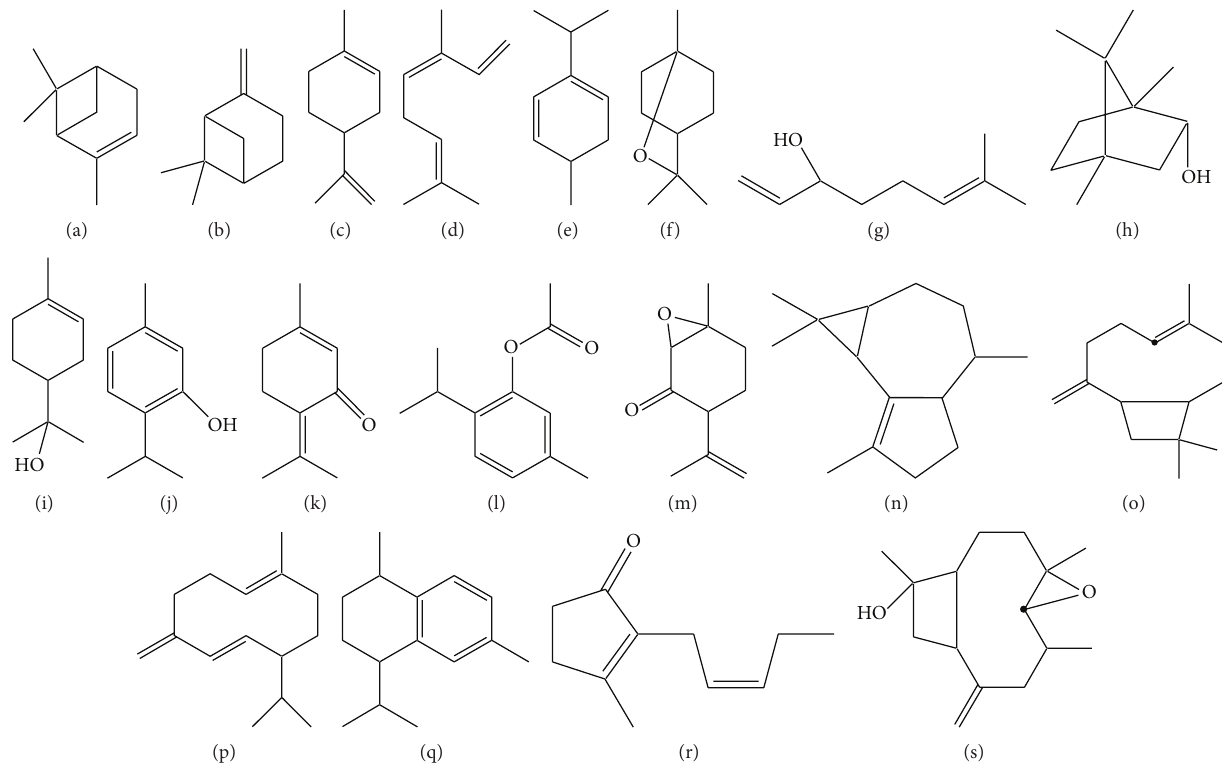
Figure 1: Structure of major compounds detected from M. longifolia essential oil. (a) 𝛼 -Pinene; (b) 𝛽 -pinene; (c) limonene; (d) cis - 𝛽 -ocimene; (e) 𝛿 -terpinene;(f)1,8-cineole;(g)linalool;(h)borneol;(i) 𝛼 -terpineol;(j)thymol;(k)piperitenone;(l)thymolacetate;(m)piperitenoneoxide; (n) 𝛼 -gurjunene; (o) 𝛽 -caryophyllene; (p) germacrene D; (q) calamenene; (r) cis- jasmone; (s) caryophyllene oxide.